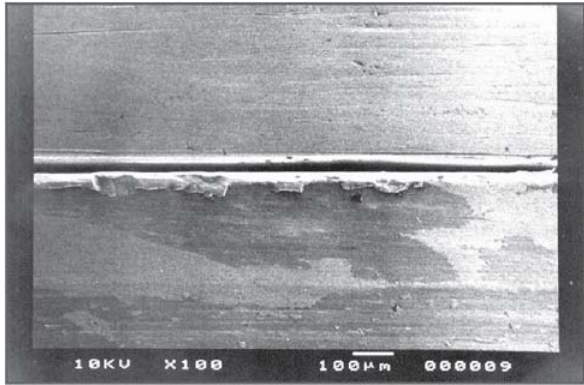
FIGURE 4B- Scanning electron microscope, Ni-Cr-Be premachined